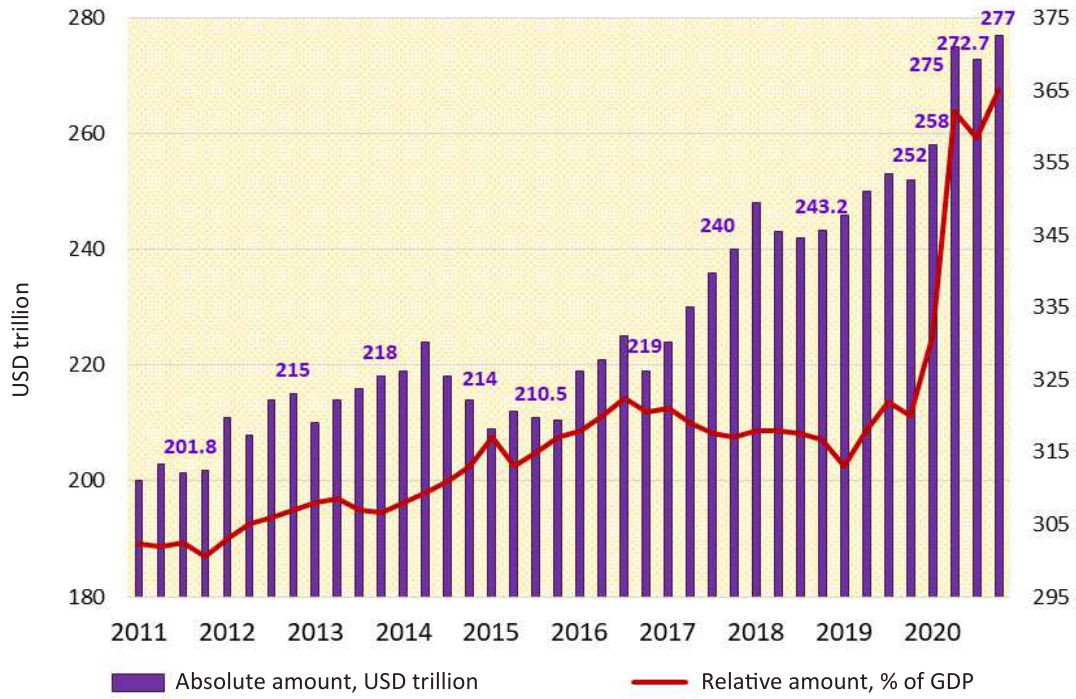
Absolute amount, USD trillion Relative amount, % of Figure 1. Global debt in relative and absolute terms in 2011–2020